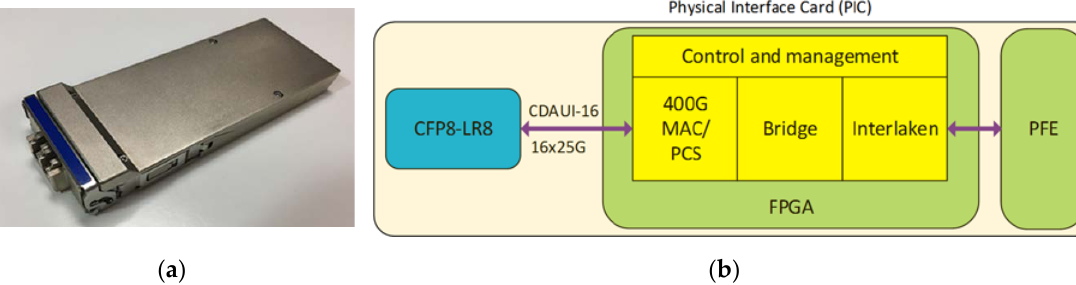
Figure 5. ( a ) Picture of 400GE CFP8-LR8 pluggable optical transceiver; ( b ) configuration of physical